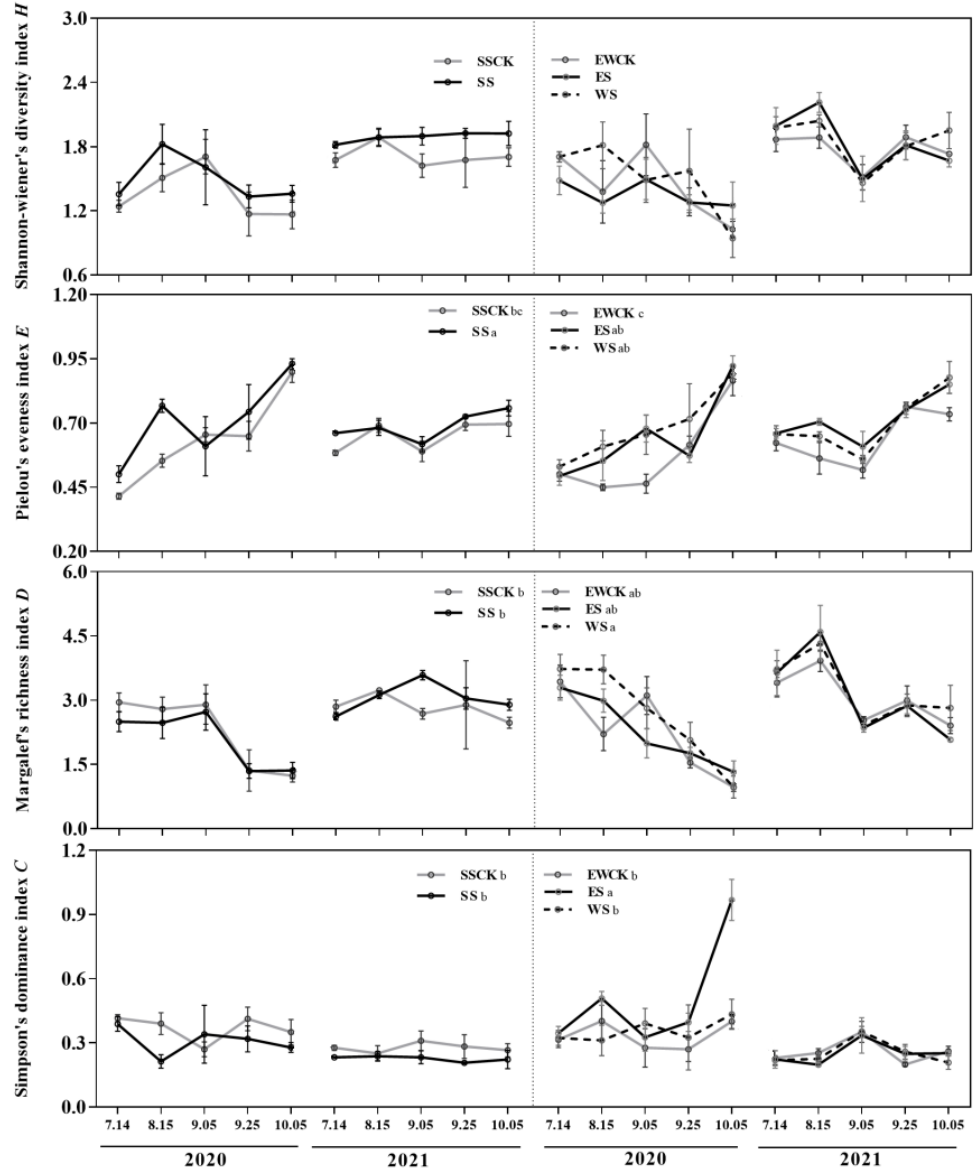
Figure 6. Community diversity indices of the insects that were collected in the tea plantation roadside trees used for ecological shading. (Note: different lowercase letters indicate significant differences among the ecological-shade treatments, and the control no-shading treatments, using the LSD test at p <